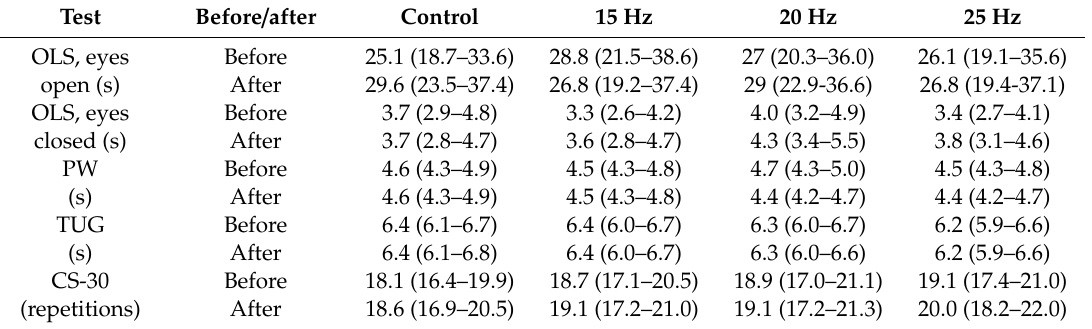
Table 1. The results of balance and mobility tests obtained before and after intervention under di ff erent exposure conditions. Values are shown as geometric mean (95% CI) (n =